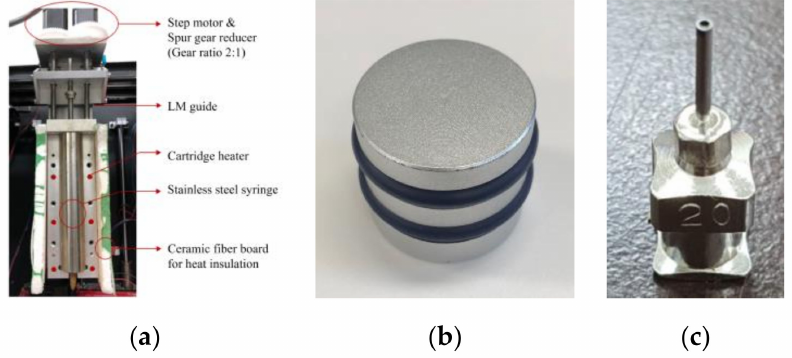
Figure 1. Photographs of ( a ) the material extruder, ( b ) the piston head, and ( c ) the